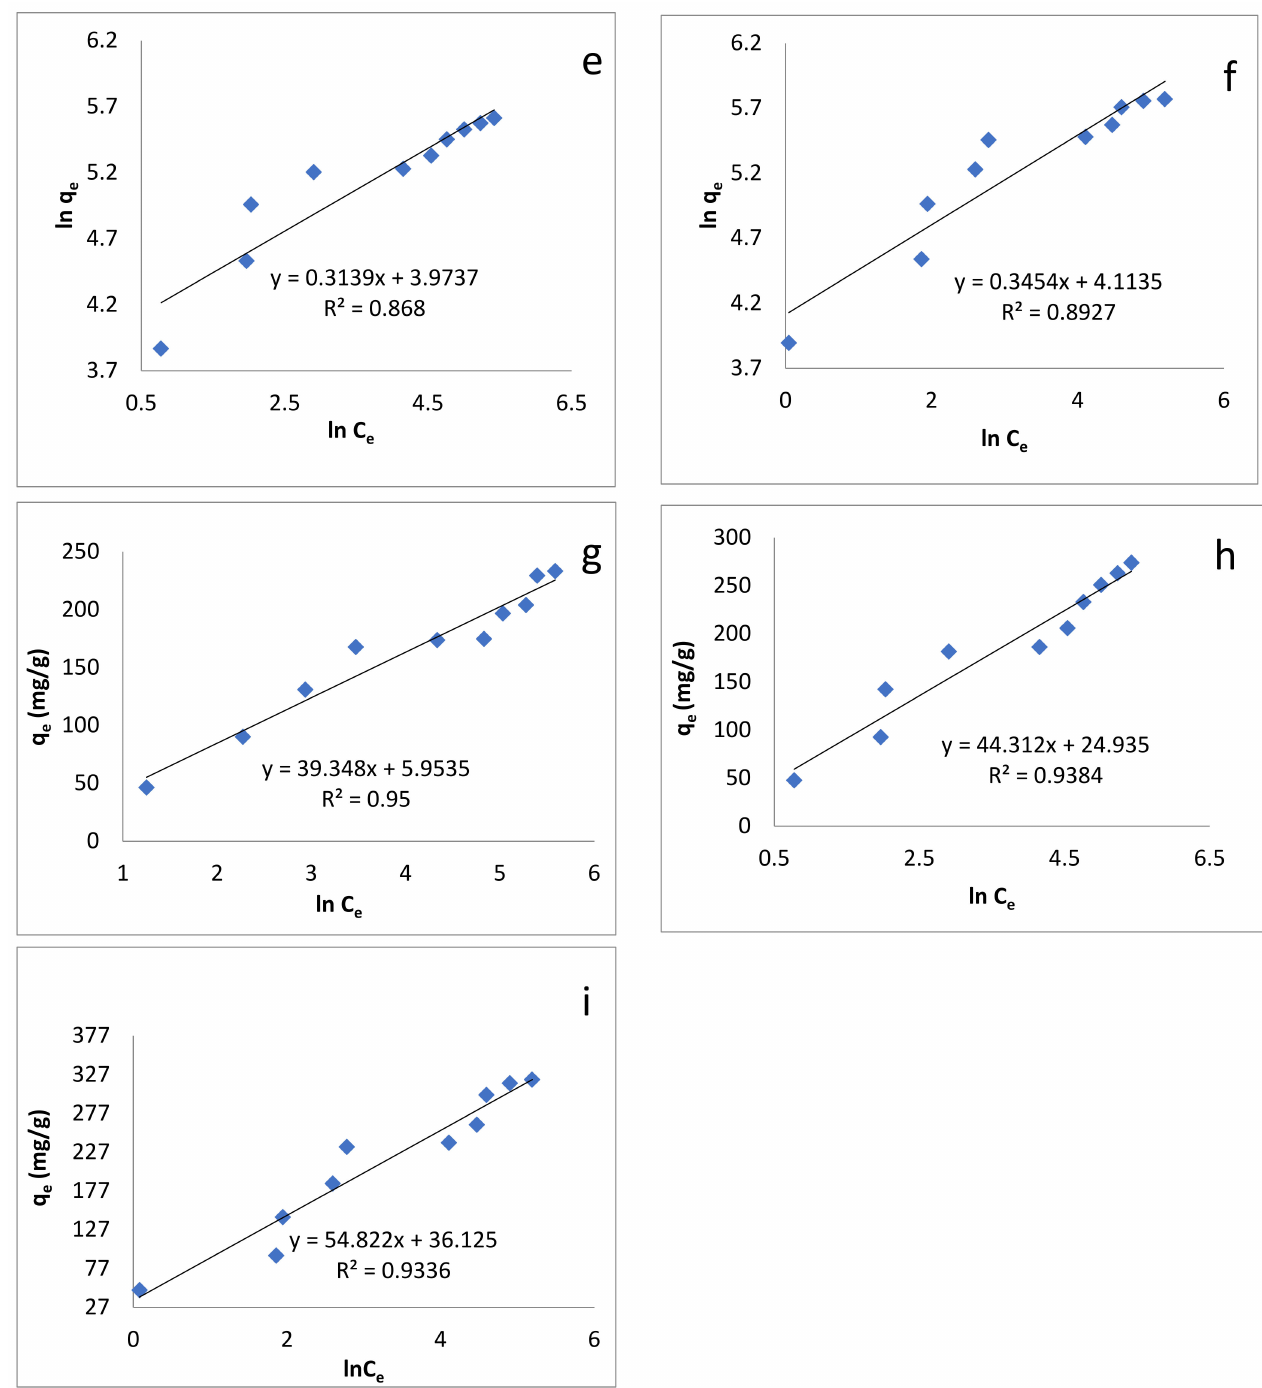
Figure 7. Adsorption isotherm models: ( a ) Langmuir isotherm at 293 K; ( b ) Langmuir isotherm at 313 K; ( c ) Langmuir isotherm at 333 K; ( d ) Freundlich isotherm at 293 K; ( e ) Freundlich isotherm at 313 K; ( f ) Freundlich isotherm at 333 K; ( g ) Temkin isotherm at 293 K; ( h ) Temkin isotherm at 313 K; ( i ) Temkin isotherm at 333